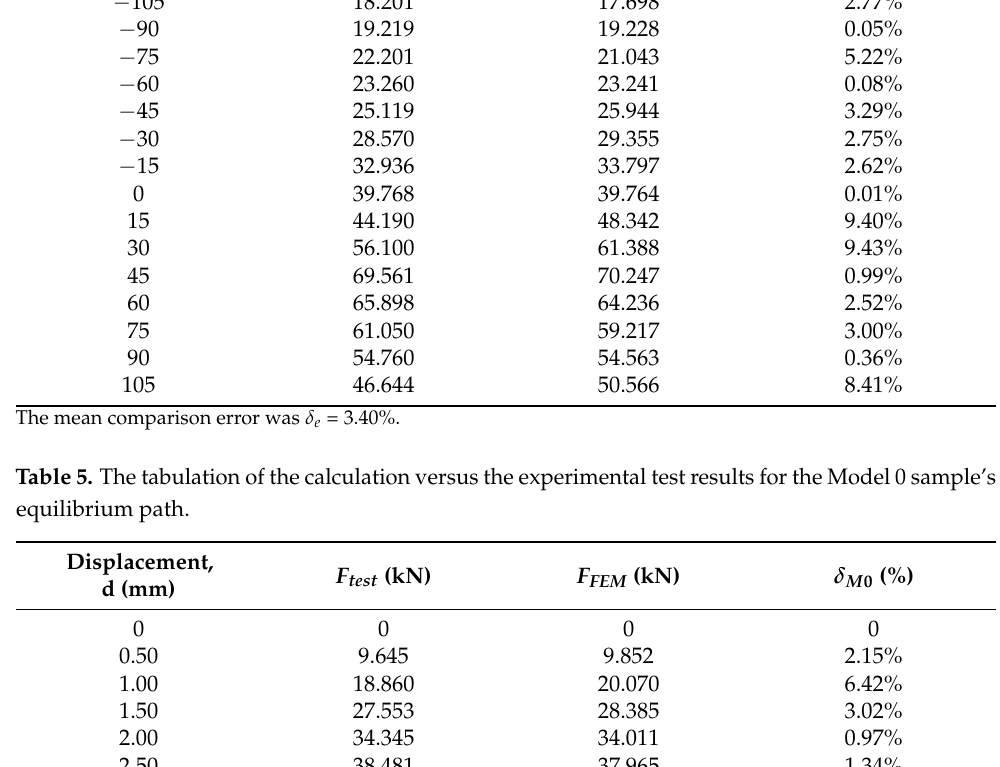
Table 4. The tabulation of the calculation versus the experimental test results at different eccentricities. Eccentricity, e (mm)